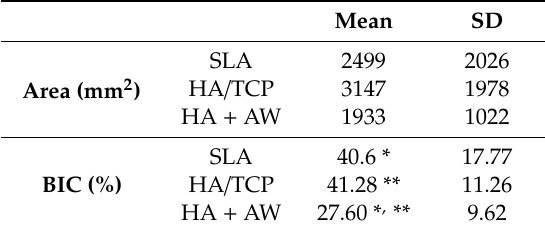
Table 6. Data referring to the bone area and bone–implant contact